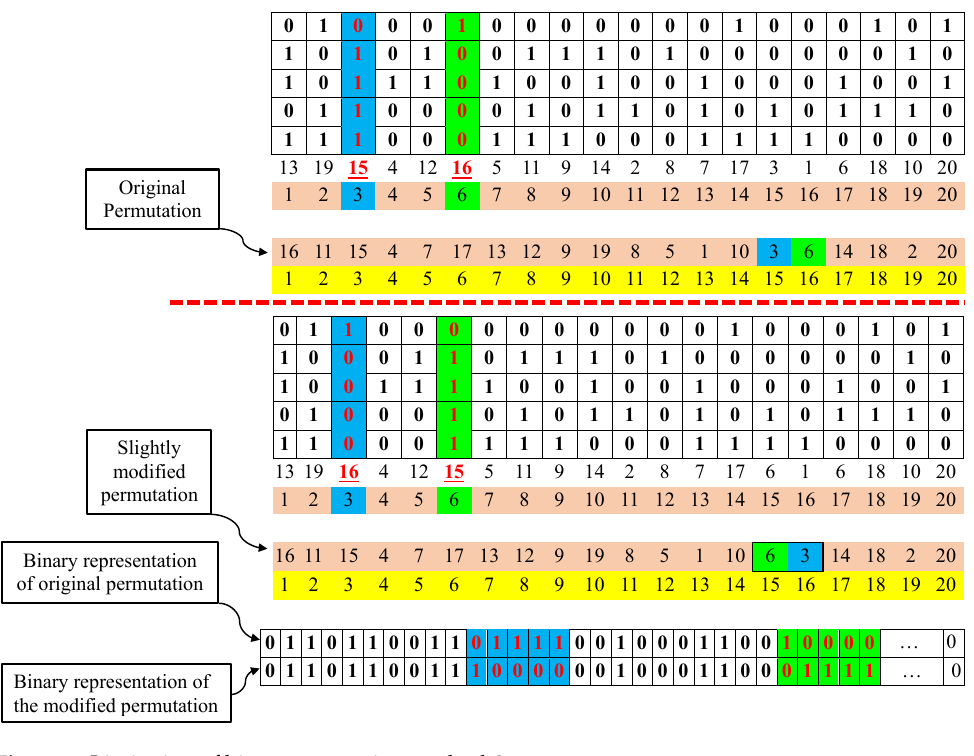
Figure 3. Limitation of binary conversion